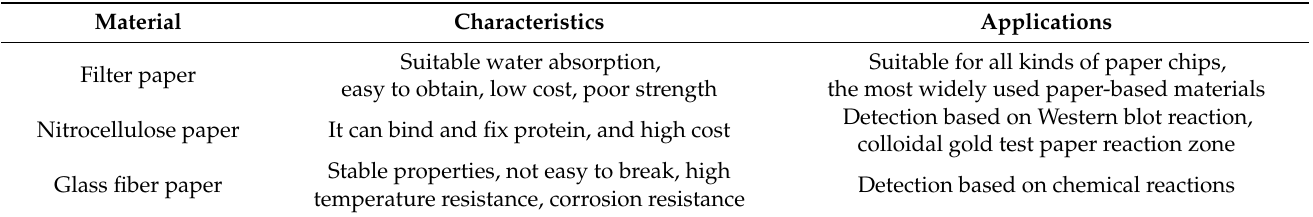
Table 1. Materials of paper-based microfluidic chips [12–14].